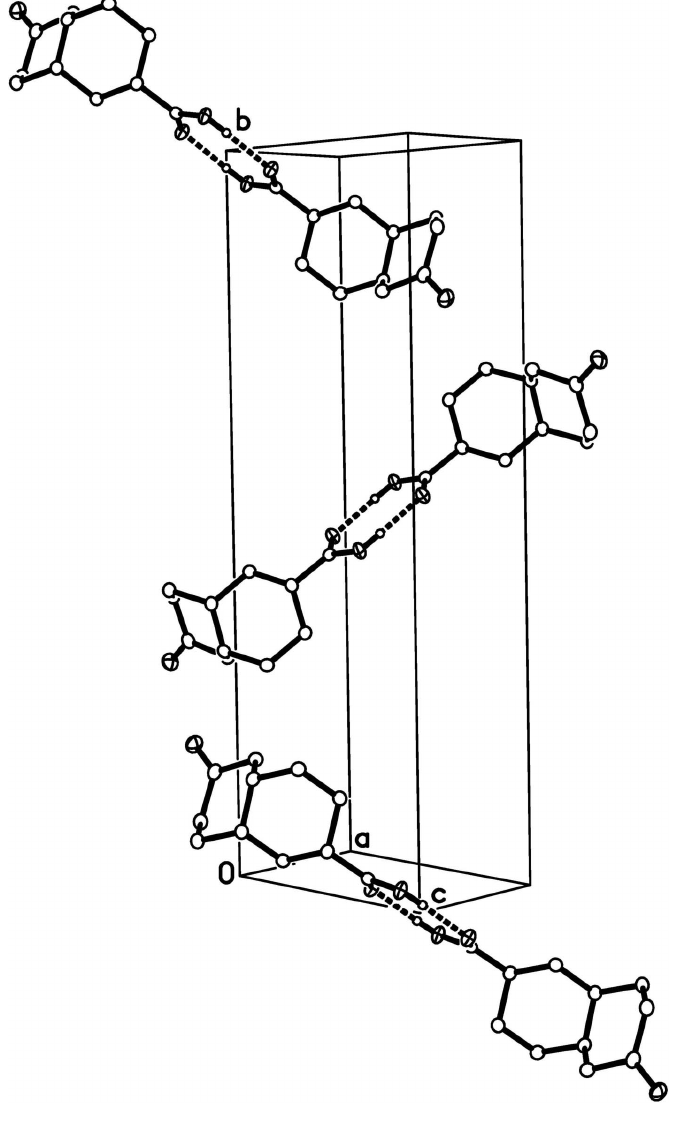
Partial packing diagram illustrating the pairing of molecules into centrosymmetric dimers centered at 1/2,1/2,1/2 and 0,0,0. All carbon-bound H atoms are omitted and displacement ellipsoids are drawn at the 40% probability level for non- H